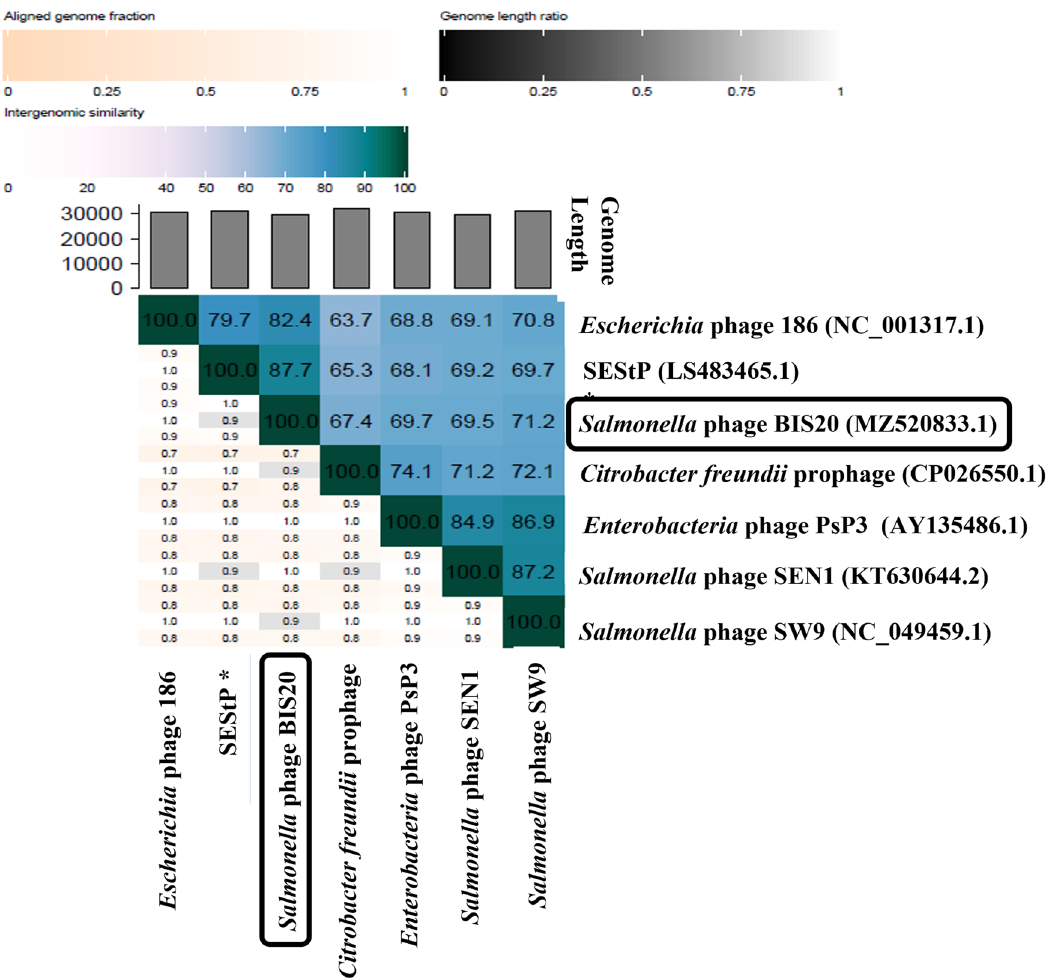
Figure 6. Heatmap generated by comparative genome analysis of Salmonella phage BIS20 with closest phage and prophage homologs in BLASTn using VIRIDIC software (http:// rhea. icbm. uni- olden burg. de/ VIRID IC/). Numbers in chart represent the homology percentage. *SEStP ( Salmonella enterica sub species enterica serovar Senftenberg